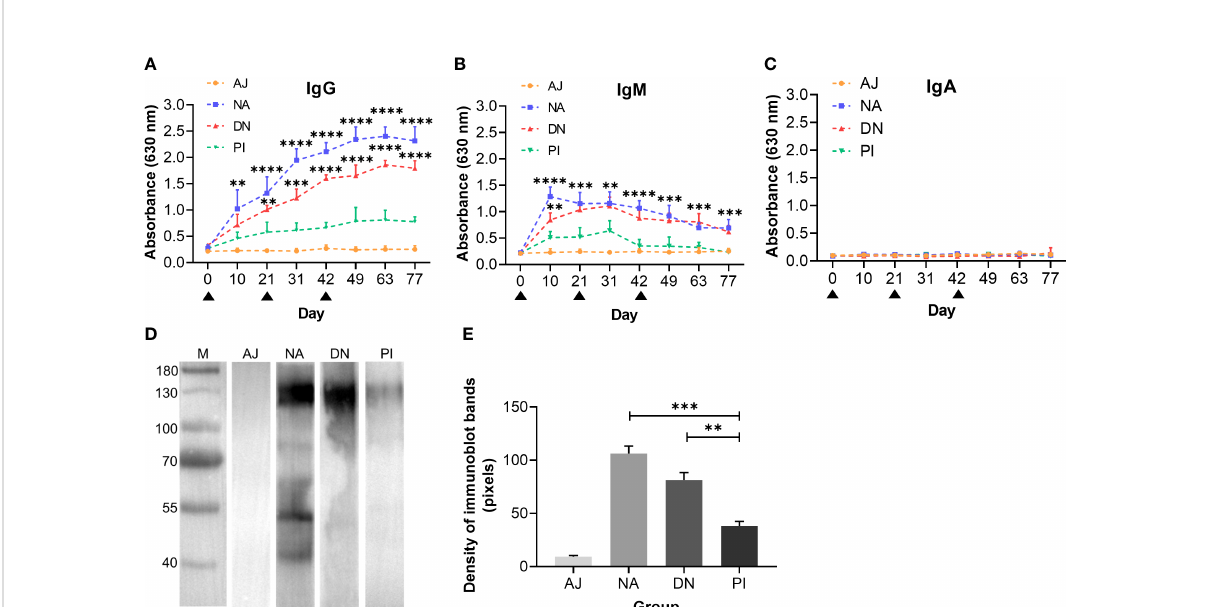
FIGURE 5 N-glycan moieties on H11 induce a highly-speci fi c anti-H11 IgG antibody response in goats immunised with H11 antigens of Haemonchus contortus. Speci fi c anti-H11 subtype antibody (IgG, IgM and IgA) responses in four groups of goats immunised with adjuvant (AJ), native H11 (NA), denatured H11 (DN) and periodate-treated H11 (PI), were determined by enzyme-linked immunosorbent assay (ELISA) and immunoblot analysis (for IgG only). (A – C) Dynamics of anti-H11 IgG (A) , IgM (B) and IgA (C) serum antibody responses in four groups of goats (AJ, NA, DN and PI) at eight time points (days 0, 10, 21, 31, 42, 49, 63 and 77, cf. Figure 4A). Each data point (absorbance at 630 nm) denoted the mean group antibody titers (mean ± SD; AJ, n = 5; NA, n = 5; DN, n = 5 and PI, n = 4). The black triangles indicated three time points of goat immunisation (days 0, 21, and 42, cf. Figure 4A) and asterisks represented statistically signi fi cant differences compared to Group PI (** p < 0.01, *** p < 0.001 and **** p < 0.0001). (D) Immunoblot of IgG antibodies binding to native H11. Four IgG antibodies were puri fi ed from pooled sera samples (collected on day 42 of the immunisation trial, cf. Figure 4A) from individual animal groups (AJ, NA, DN or PI). (E) Densities of four immunoblot bands were quantitatively analysed using the ImageJ program (NIH, USA). Data represent the mean ± SEM from three independent